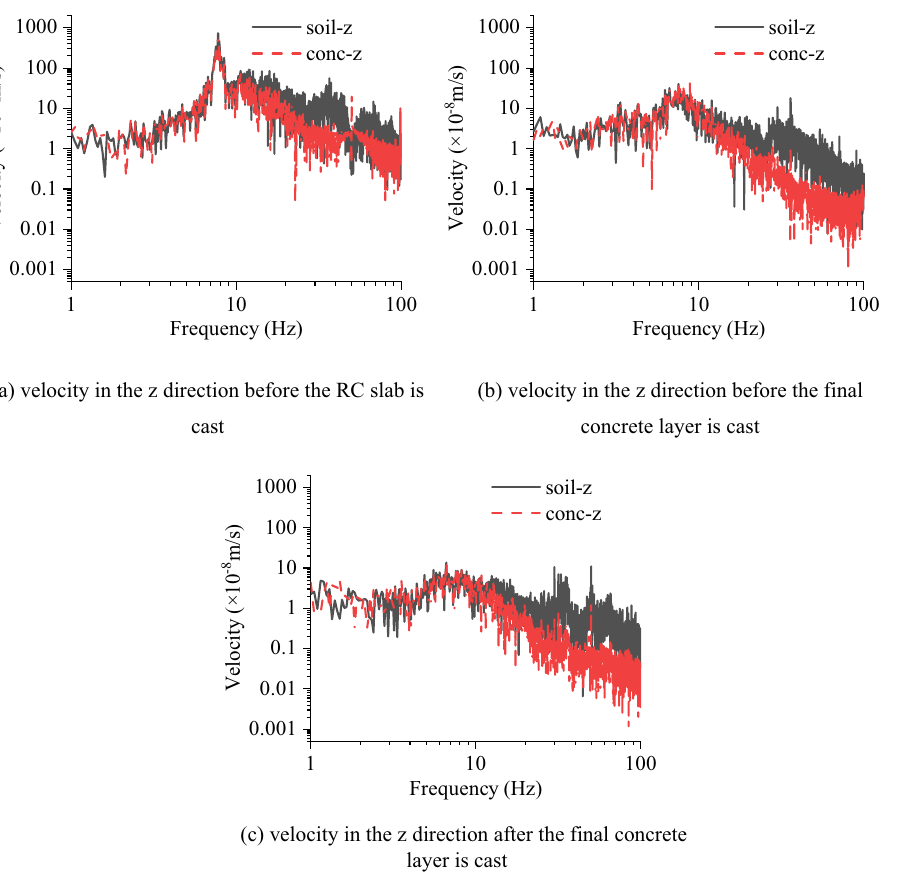
Figure 15. Frequency spectrum of the measured velocities on the concrete layer and adjacent subsoil in different construction periods at